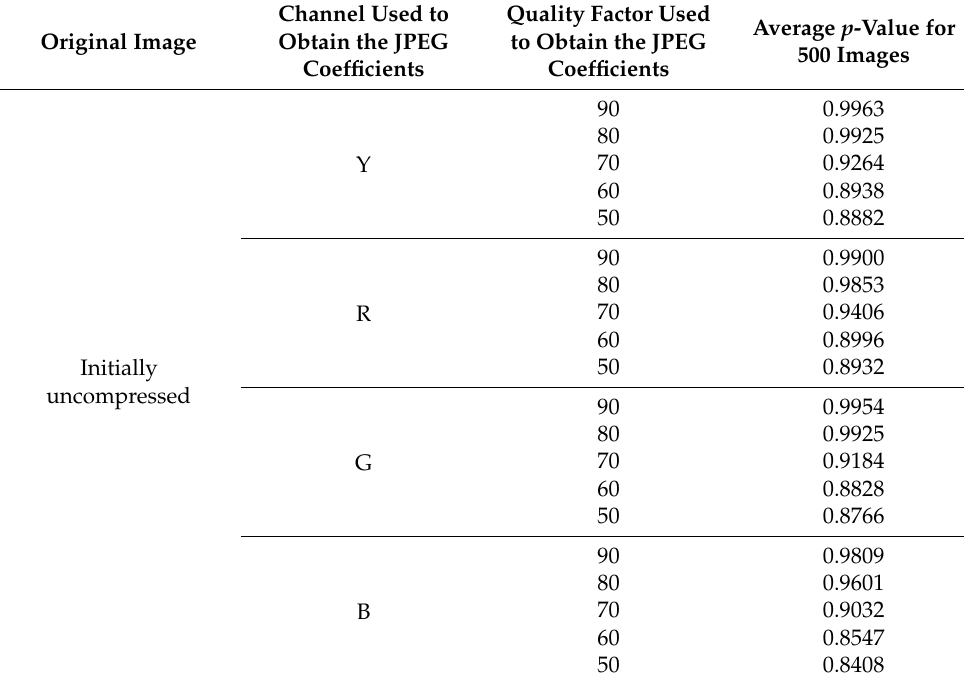
Table 3. Comparison between JPEG coefficients and the GBL for uncompressed